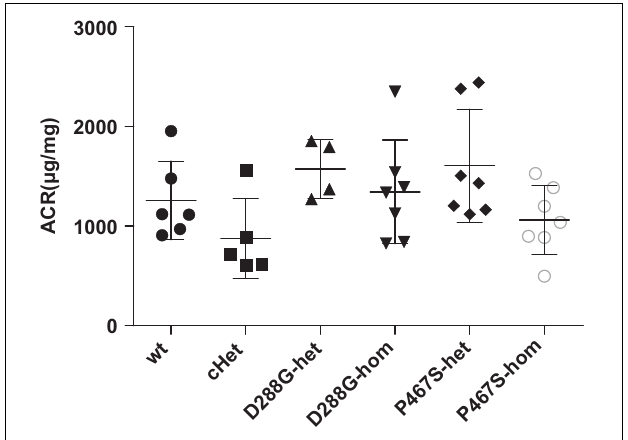
FIGURE 3 | The albuminuria of mice of CFI-D288G/P467S cHet and other genotypes after LPS treatment. Thirty-six hours after the first 10 mg/kg LPS injection, spot urine samples were collected and subjected to ACR measurement. Wt, n = 6; cHet, n = 5; D288G-Het, n = 4; D288G-Hom, n = 7; P467S-Het, n = 7; and P467S-Hom, n = 7. ANOVA analysis was performed and showed no statistically significant differences among the groups ( p = 0.071).